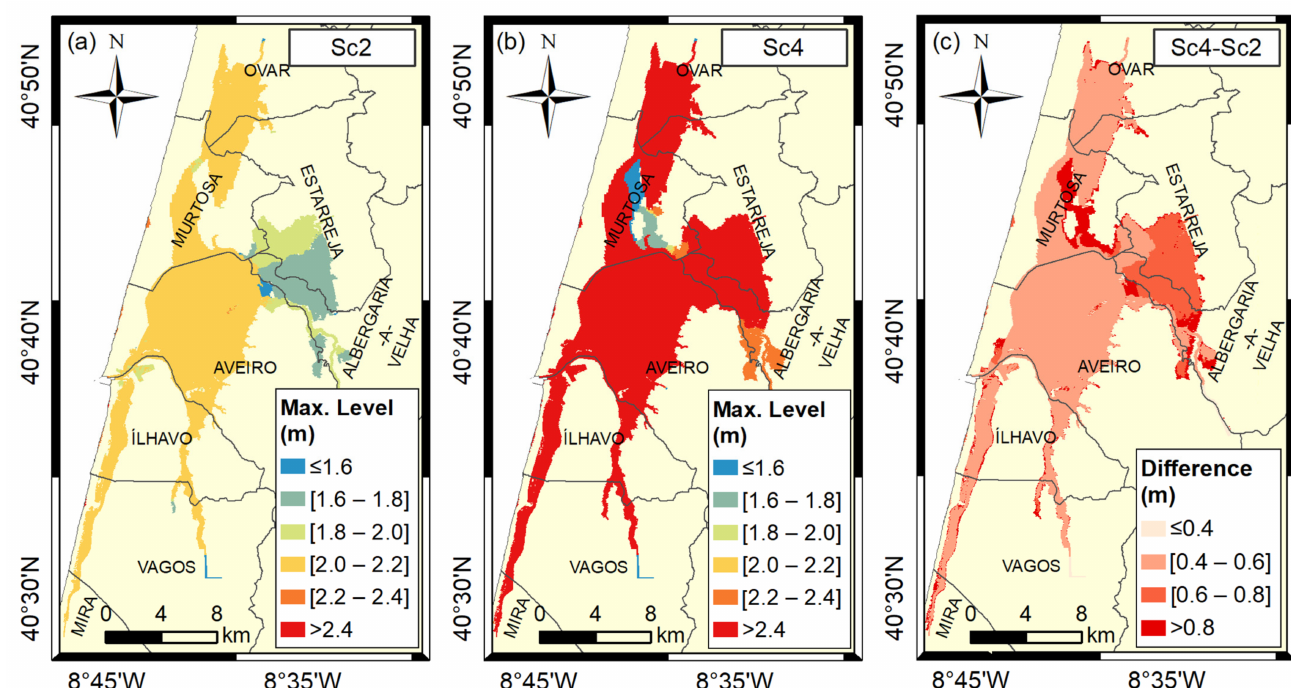
Figure 7. Maximum sea surface elevation caused by a 2-year return period storm surge under present MSL ( a ) and future MSL ( b ). The difference between the two scenarios ( c